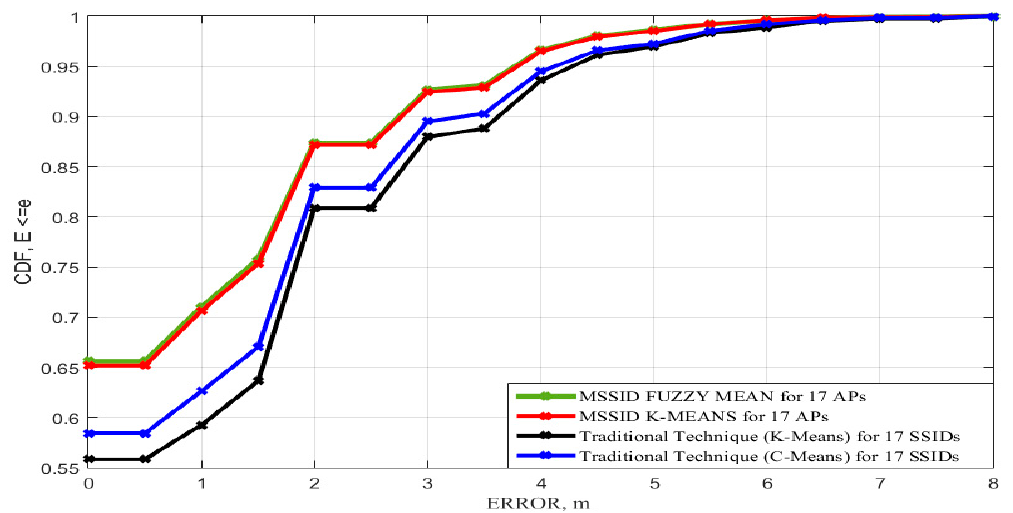
Figure 17. The proposed technique performance with the Fuzzy C-mean and K-mean approaches.